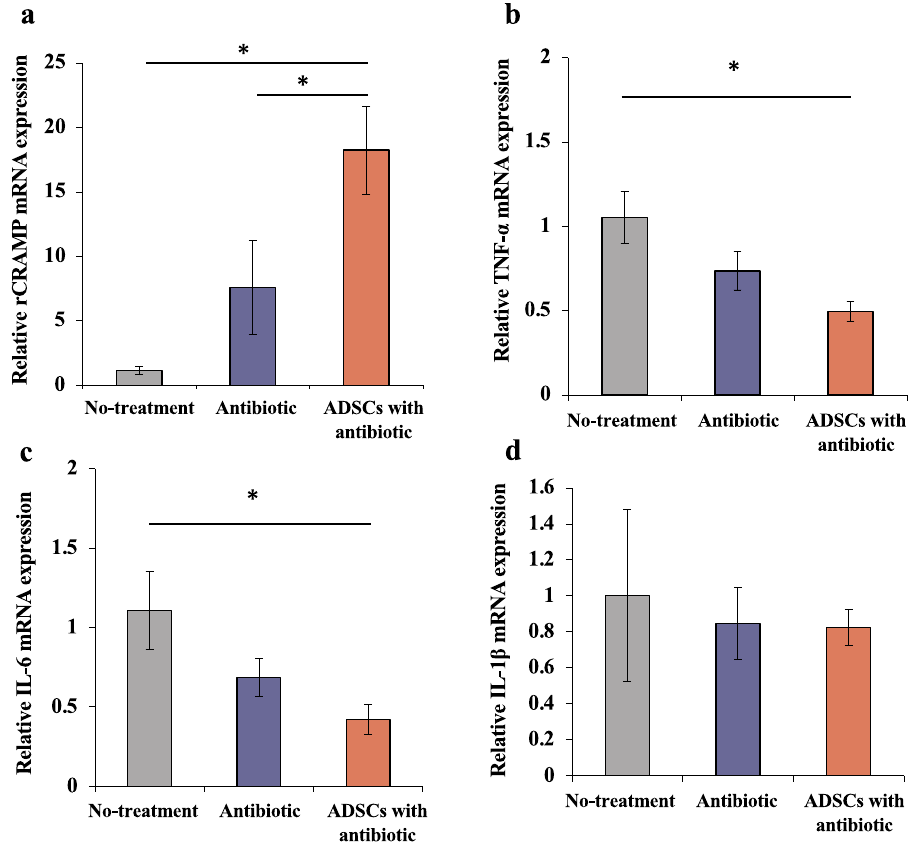
Figure 7. Real-time reverse transcription–polymerase chain reaction (RT-PCR). ( a-d ) Gene expression of rCRAMP,TNF-α, IL-6, and IL-1β in the three groups. All statistical analyses were performed using Welch ANOVA followed by Tukey HSD post-test (n = 6 rats per group). The error bars are defined as standard error of the mean. *p < 0.05. mRNA messenger ribonucleic acid, rCRAMP rat cathelicidin-related antimicrobial peptide,